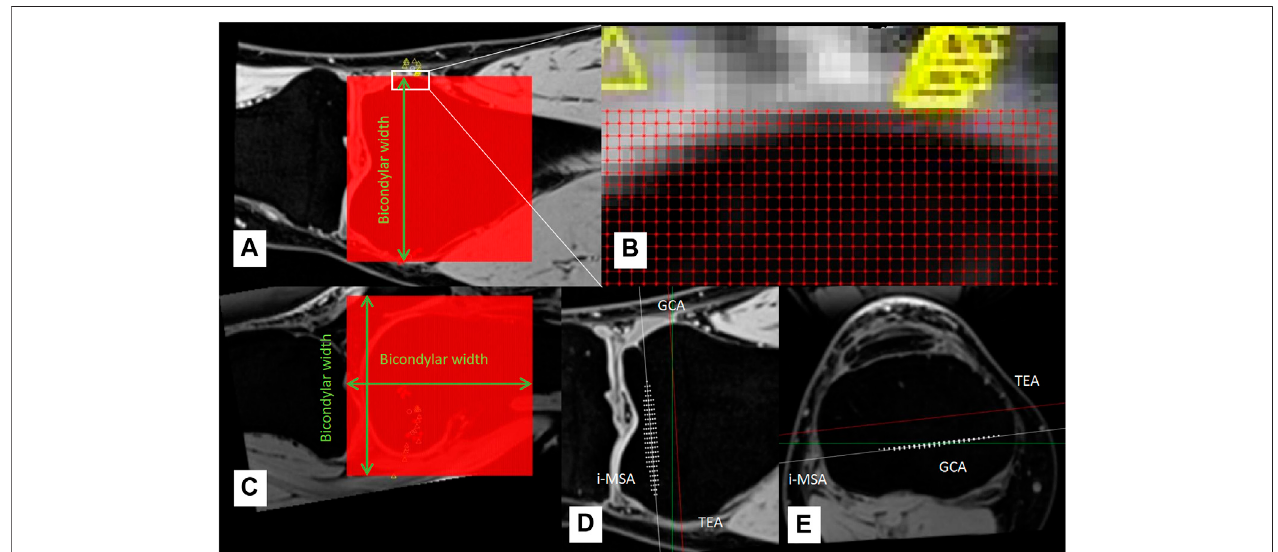
FIGURE 7 | (A – C) A cube grid with the side length of bicondylar width was established at the distal end of the femur, the grid spacing was 1 mm, and all grid intersections were candidate reference points. (D – E) White asterisks represent the 0.2% reference points with the smallest PC, which was used to determine rotation axis (individual most stable rotation axis,